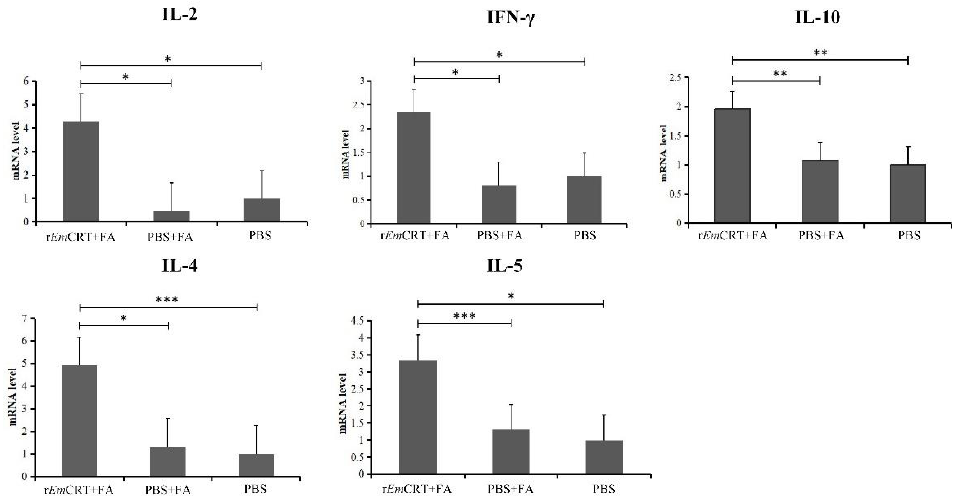
Figure 6. Splenocyte cytokine transcriptional profile of mice immunized with r Em CRT. Total cDNA was prepared from total RNA obtained from spleens of mice immunized with r Em CRT three times. The mRNA levels of IL-2, IFN- γ , IL-4, IL-5 and IL-10 were determined by RT-qPCR. Data are expressed as the mean of the ratio of each cytokine relative to GAPDH (housekeeping gene). * p < 0.05, ** p < 0.01, *** p < 0.001.